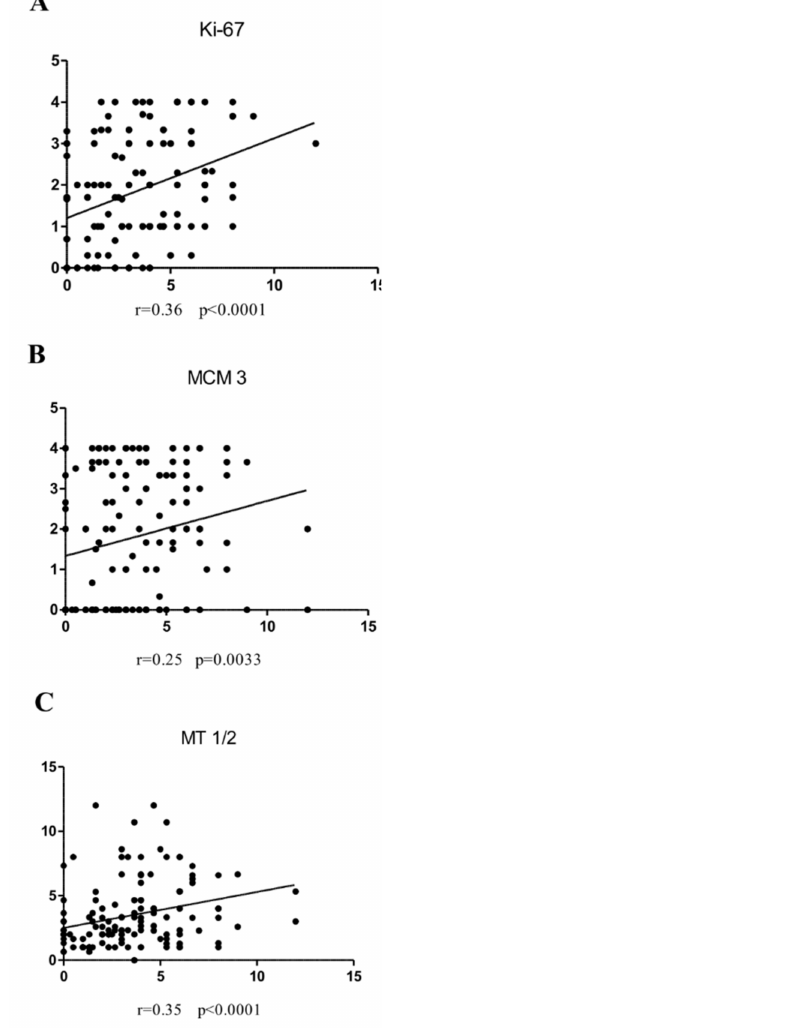
Figure 4. Correlations of irisin expression levels with diagnostic markers are moderate positive Ki-67 ( A ), weak positive MCM3 ( B ), and moderate positive MT-I/II ( C ) in LSCC